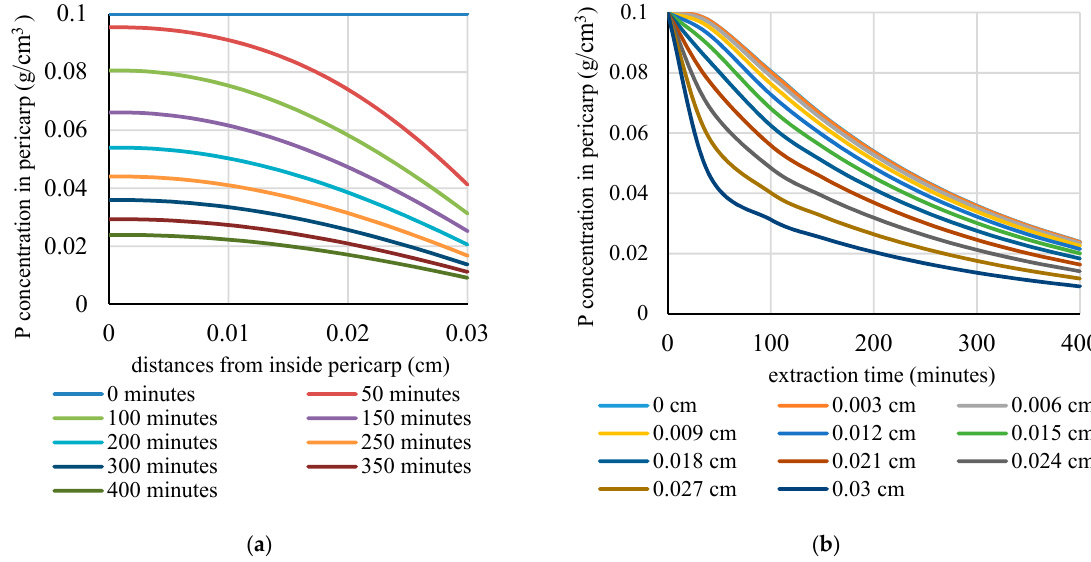
Figure 3. The profile of the phytochemical concentration inside the pericarp as a function of: ( a ) position; and ( b ) extraction time.